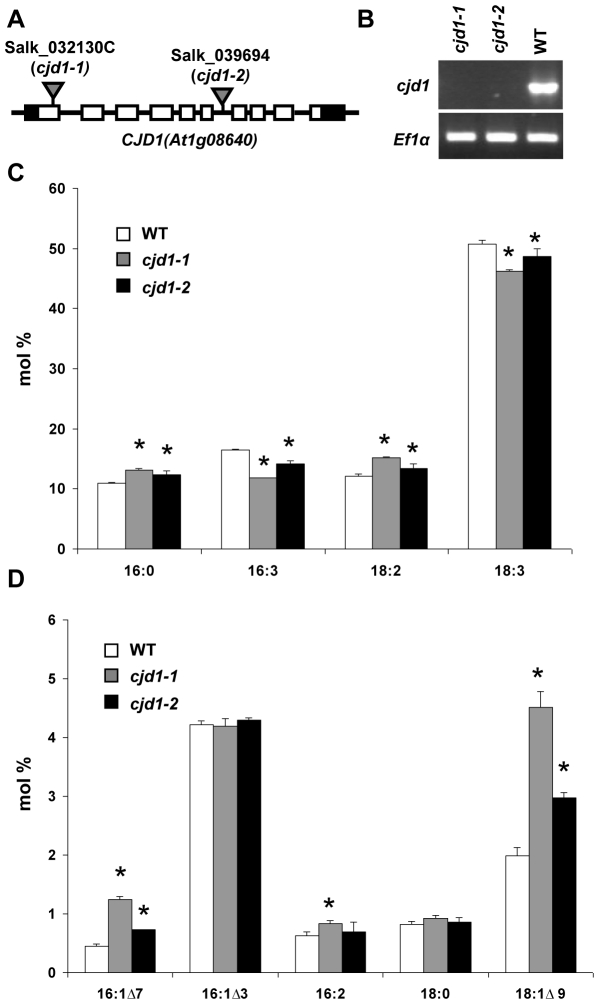
T-DNA mutants in CJD1 possess altered fatty acid profiles.A, Salk_032130C (cjd1-1) contains a T-DNA insertion in the first exon of CJD1 (At1g08640) while Salk_039694 (cjd1-2) harbors a T-DNA insertion in intron 6. T-DNA insertions are illustrated as triangles; exons, introns and untranslated regions are depicted by empty rectangles, solid lines and black rectangles, respectively. B, Semi-quantitative RT-PCR analysis shows that leaves of cjd1-1 and cjd1-2 do not accumulate detectable CJD1 transcript under the conditions tested. Wild-type plants (WT) and the elongation initiation factor 1 alpha (EFlα, GenBank accession no. X16432) were used as controls. C, and D, FAME profiles from GC-FID expressed in mol % for WT, cjd1-1 and cjd1-2. The error bars represent the standard deviation of three biological replicates and statistically significant differences relative to wild type (Student's t test P<0.01) are indicated with asterisks.